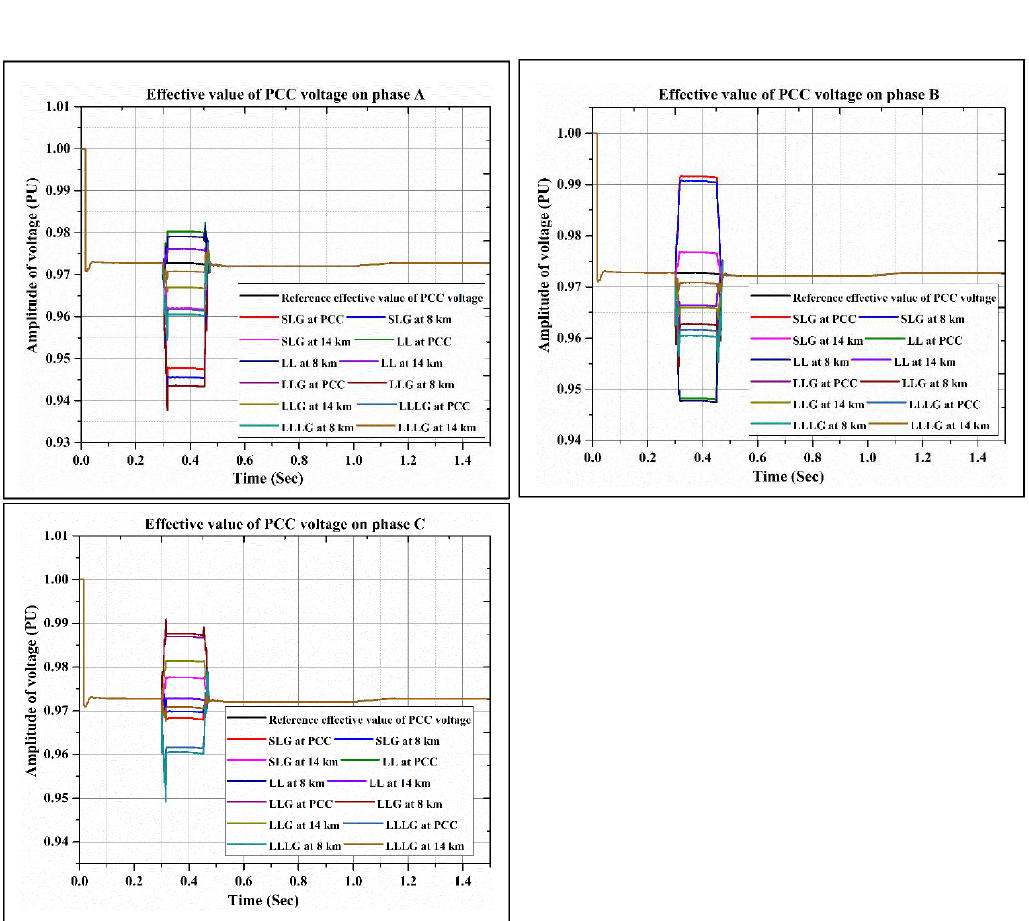
Figure 18. The effective value of PCC voltage for different grid faults.